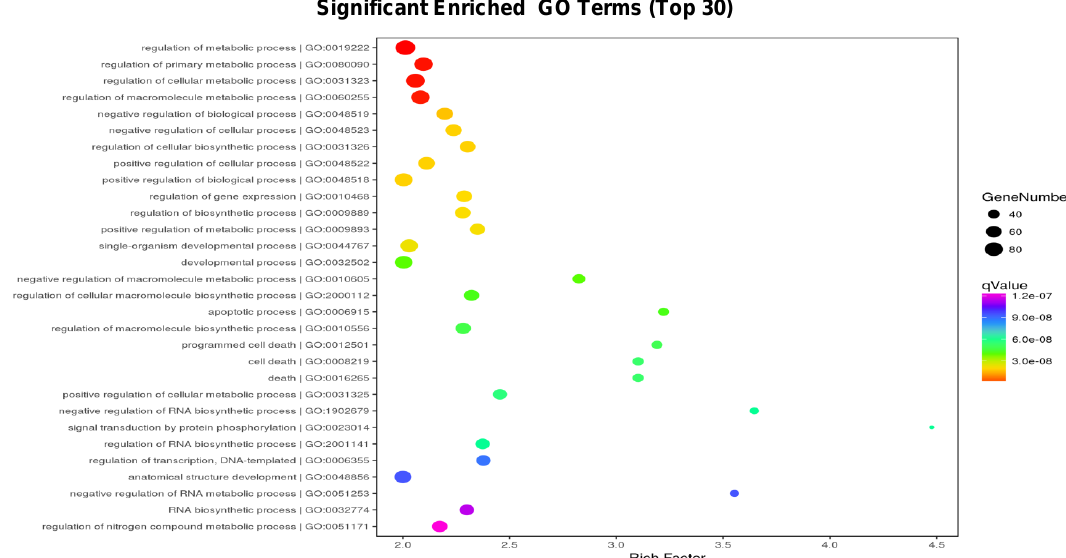
Figure 2. Gene ontology (GO) functional classification and enrichment analysis of DEGs. ( A ) GO functional classification of the DEGs. The x -axis indicates the functional description of the GO classifications, the left y -axis represents the proportion of the number of genes annotated to the GO database in the number of background genes, and the right y -axis represents the number of genes. The solid line represents the number of DEGs and the dotted line represents the total number of genes expressed in the background. All GO terms are grouped into three major categories: Blue is for biological processes, green is for cellular components, and red is for molecular function. A total of 2270 DEGs were classified to the unique gene matches, including 1375 DEGs (60.6%) to biological processes, 651 DEGs (28.7%) to cellular components, and 244 DEGs (10.7%) to molecular function. ( B ) Top 30 GO enrichment results of DEGs. The x -axis indicates –log (corrected p -value). A greater x -value represents a smaller corrected p -value, suggesting the enrichment is more significant. The y -axis represents the function descriptions of the GO terms. The regulation of metabolic processes is the most significant enriched GO term, followed by regulation of primary metabolic processes, regulation of cellular metabolic processes, and so